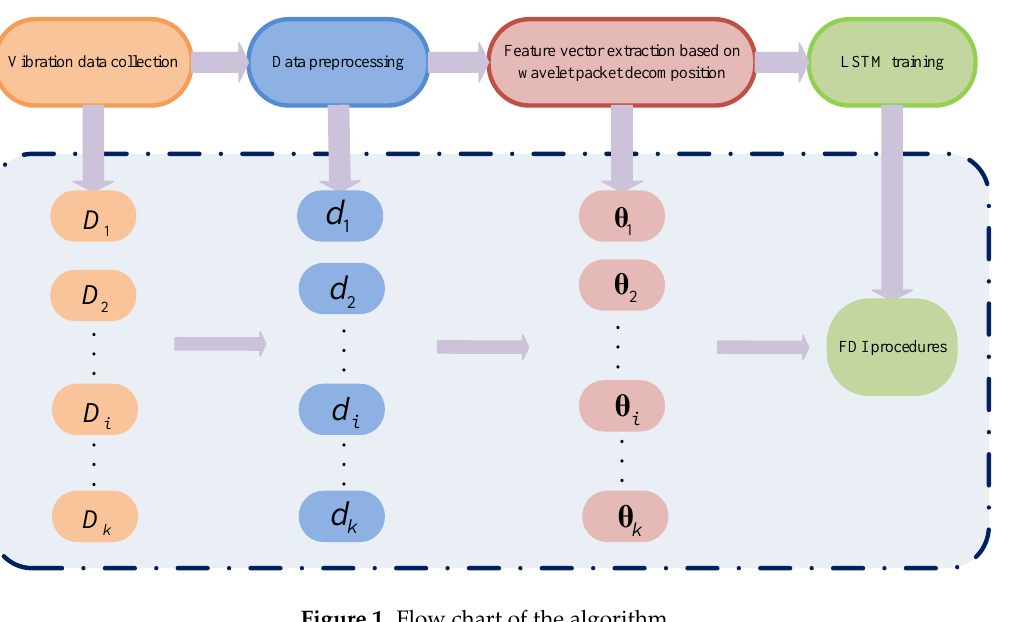
Figure 1. Flow chart of the algorithm.